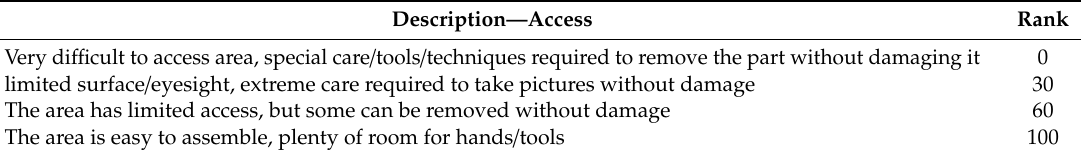
Table 2. Membership functions in tabular form of linguistic variables for “access”.